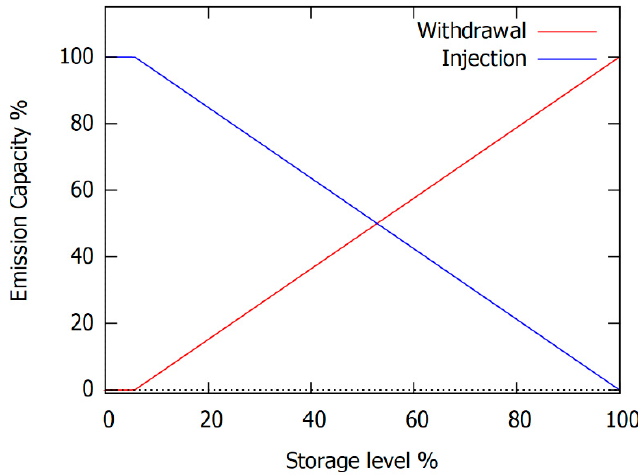
Figure 5. Injection and withdrawal curves of the gas storage unit.